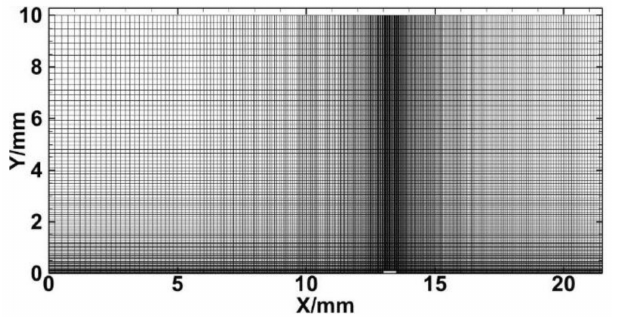
Figure 3. Computational